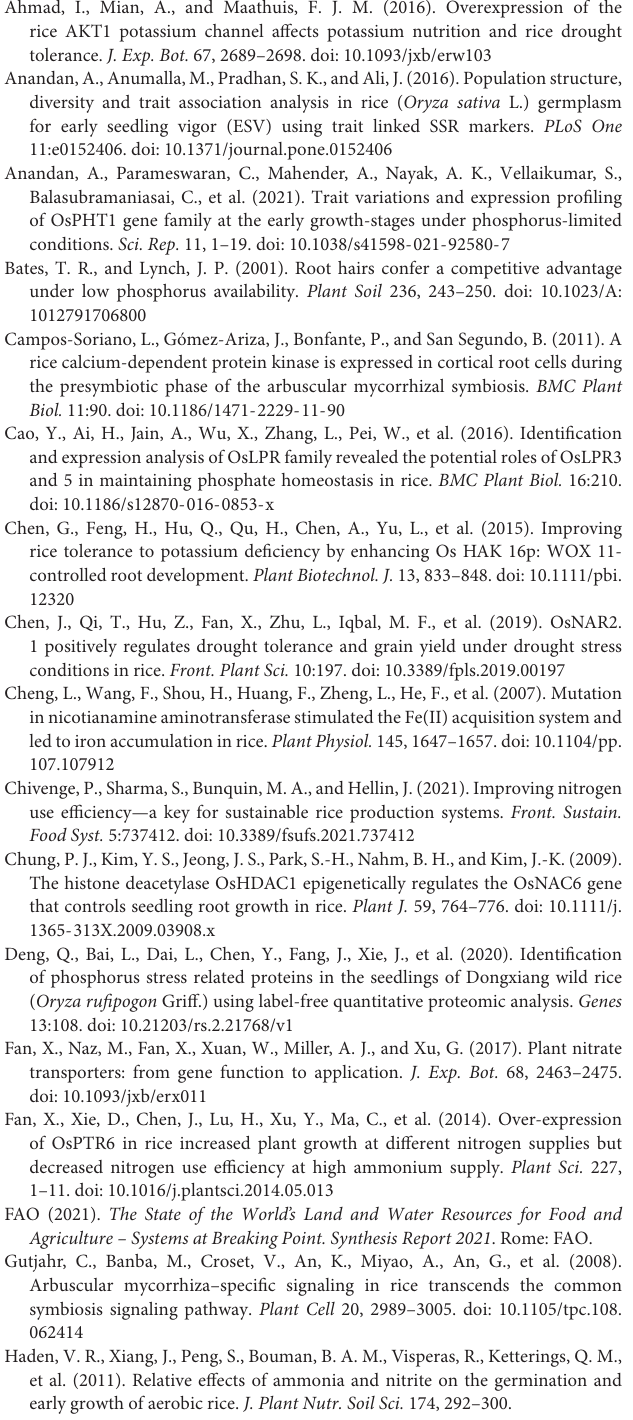
Supplementary Figure 1 | Manhattan plots from GWA mapping of early root traits at 14 and 28 days under DSR condition of BAAP population in wet season. Benjamini–Hochberg adjusted probabilities > 0.1 are highlighted in the red dot. The diagonal blue line shown on QQ Plots represents a 1:1 agreement between expected probability. Candidate gene of notable QTL is shown on the top.